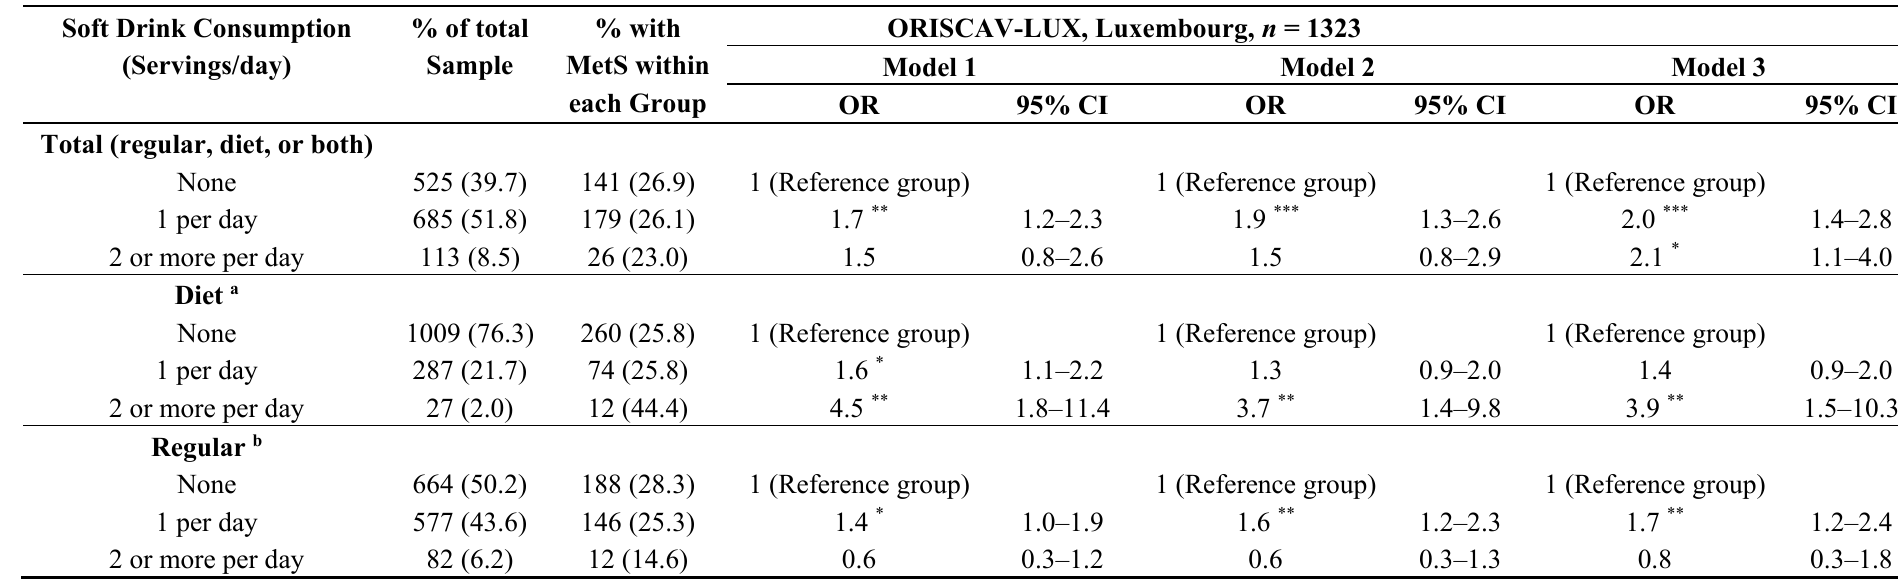
Table 3. Cross-sectional relationships between soft drink consumption with prevalence of MetS in ORISCAV-LUX ( N = 1323). Soft Drink